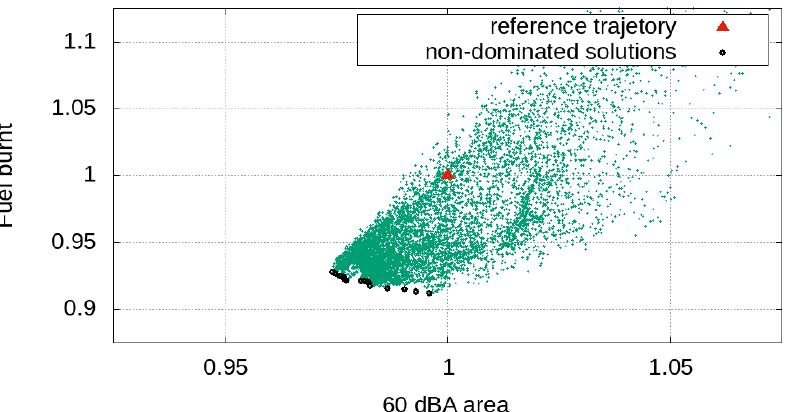
Figure 13. Approach manoeuvre for the twin-aisle aircraft: normalised DPSO solutions with reference trajectory and approximated Pareto front.